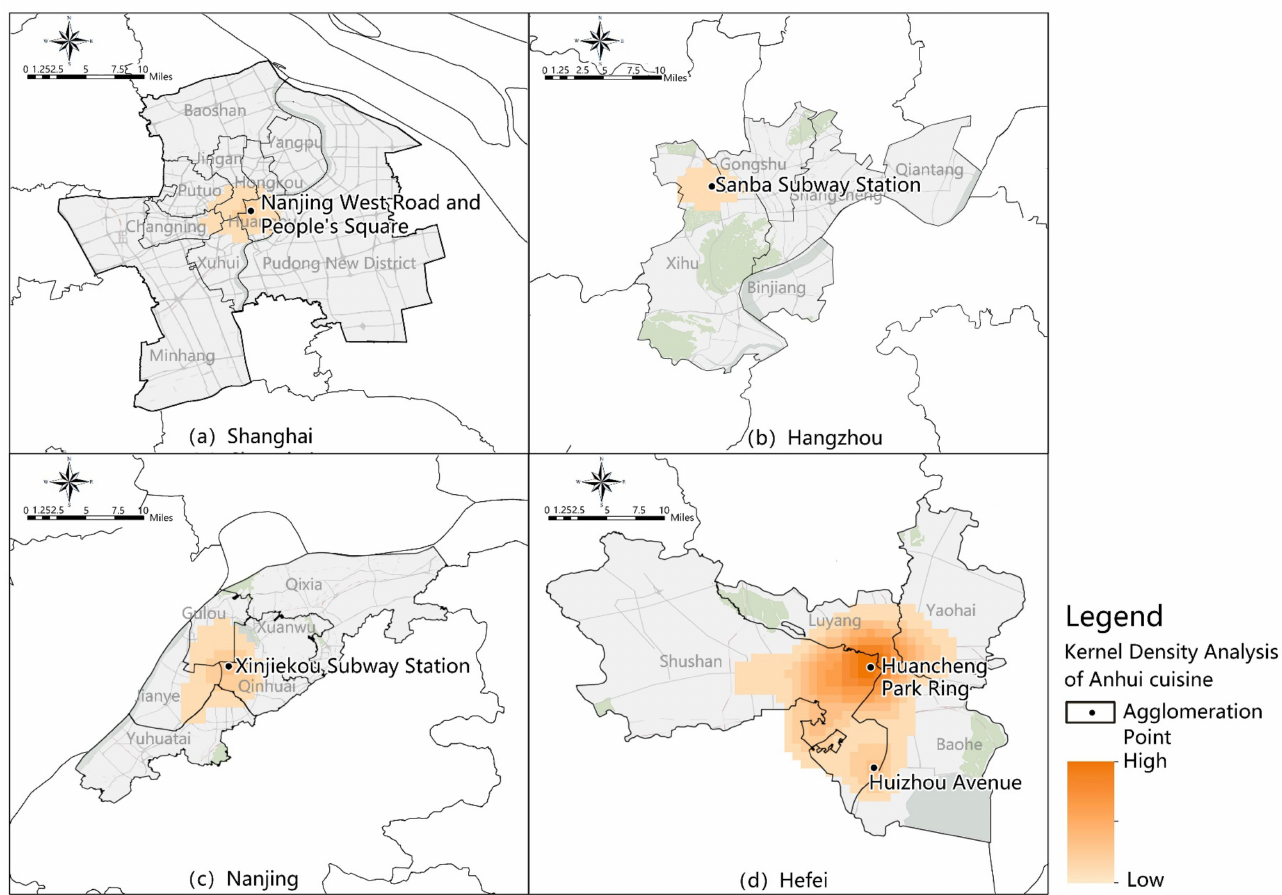
Figure 9. Kernel density analysis of Anhui cuisine in the main urban areas of the four central cities in the